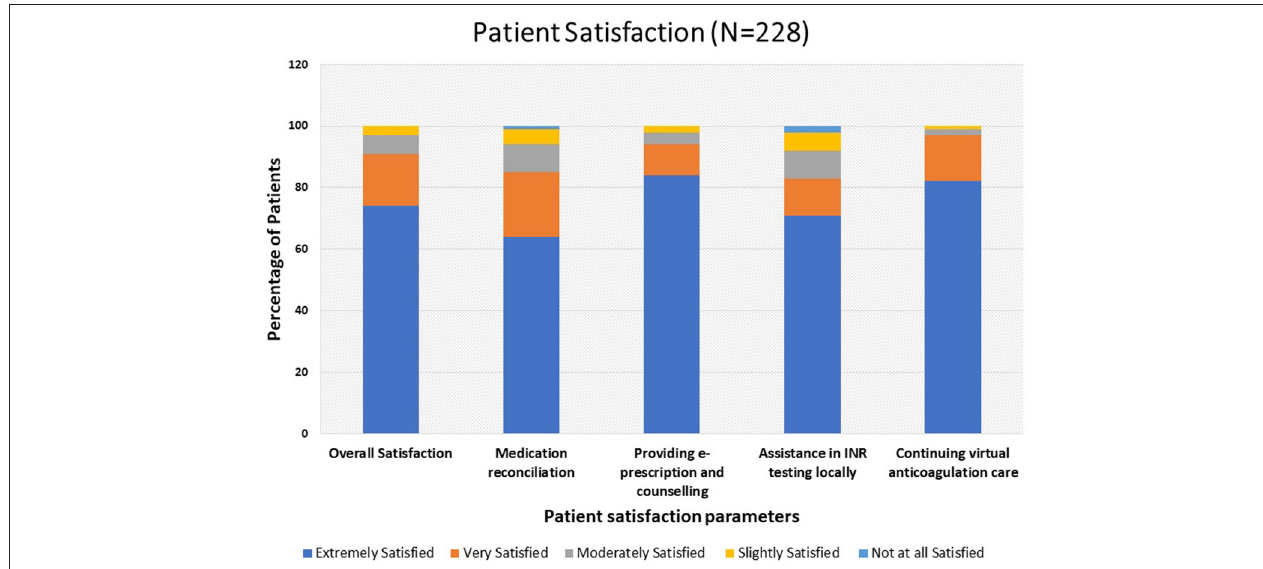
FIGURE 2 | Patient satisfaction toward VAC care during